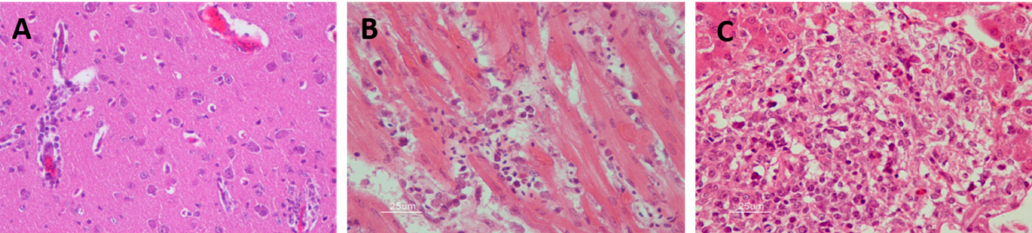
Figure 5. Histopathological findings in WNV-infected red-legged partridge. ( A ) Moderate gliosis, and lymphoplasmacytic and histiocytic perivascular cu ff s observed in the brain. ( B ) Extensive myocardial degeneration and necrosis with inflammatory infiltrate composed of lymphocytes, plasma cells, and histiocytes observed in the heart. ( C ) Extensive liver necrosis with predominantly lymphoplasmacytic infiltrate. Images courtesy of Dr. U. Höfle and Dr. V.